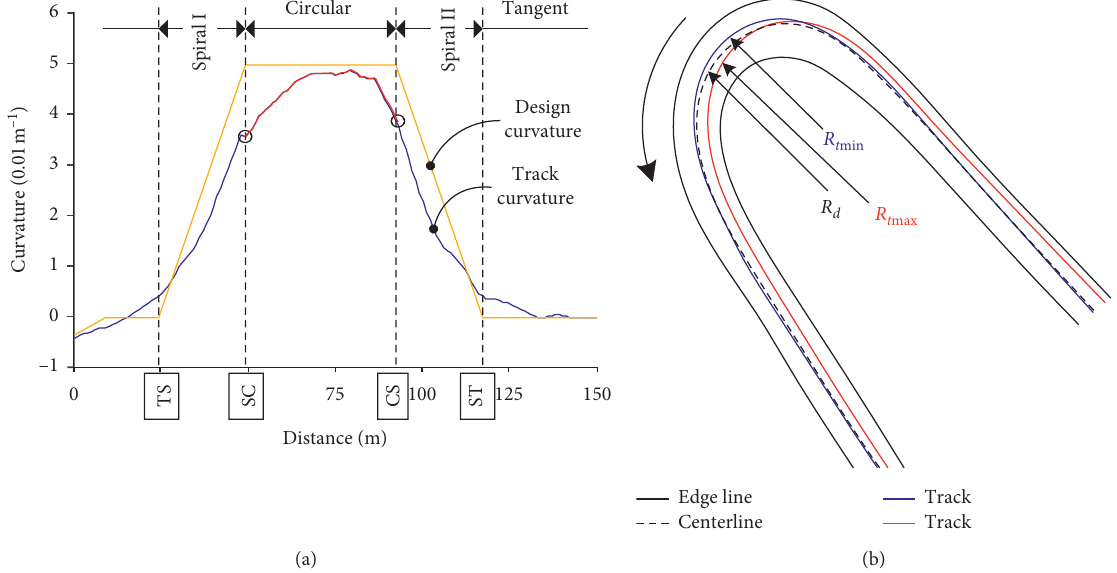
Figure 14: Calculation and illustration of track equivalent radius. (a) Calculation of track equivalent curvature and (b) illustration of track equivalent radius.